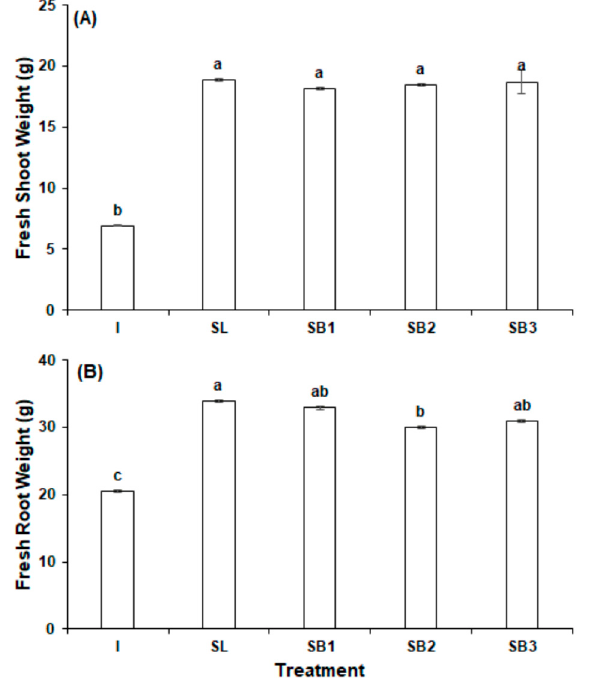
Figure 1. Fresh weight of radish in experiment 1: ( A ) shoot weight ( B ) root weight. All different letters are significant at p < 0.05.